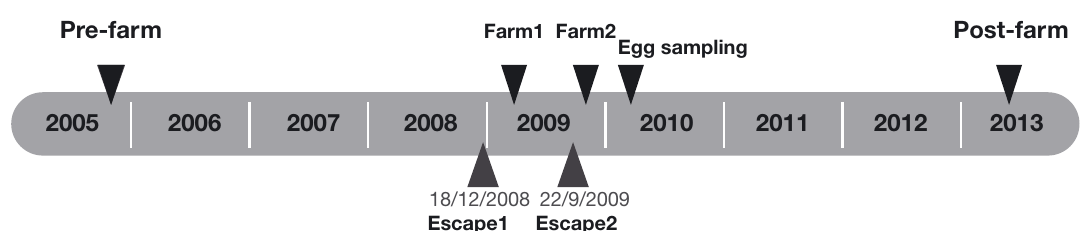
Fig. 2. Timeline of events in the study. Pre- and post-farming samples were taken several years prior to and after the period when the farm was operational (from December 2007 to April 2010). Escape1 was reported to consist of 25000 cod and